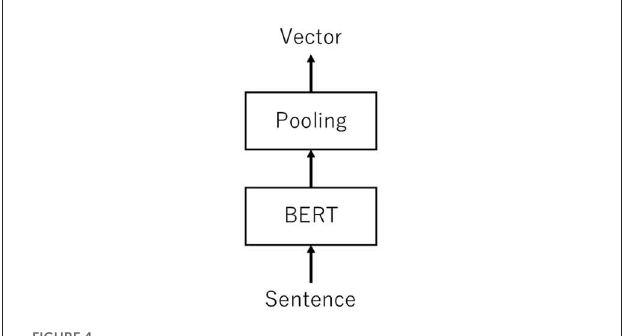
FIGURE4 Structure of sentence BERT.